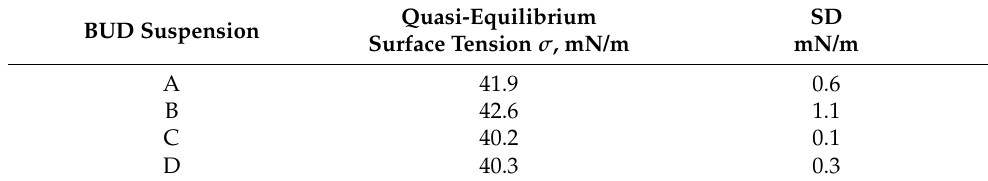
Table 4. Quasi-equilibrium (10 min) surface tension of tested BUD suspensions at 25 ± 0.5 ◦ C.